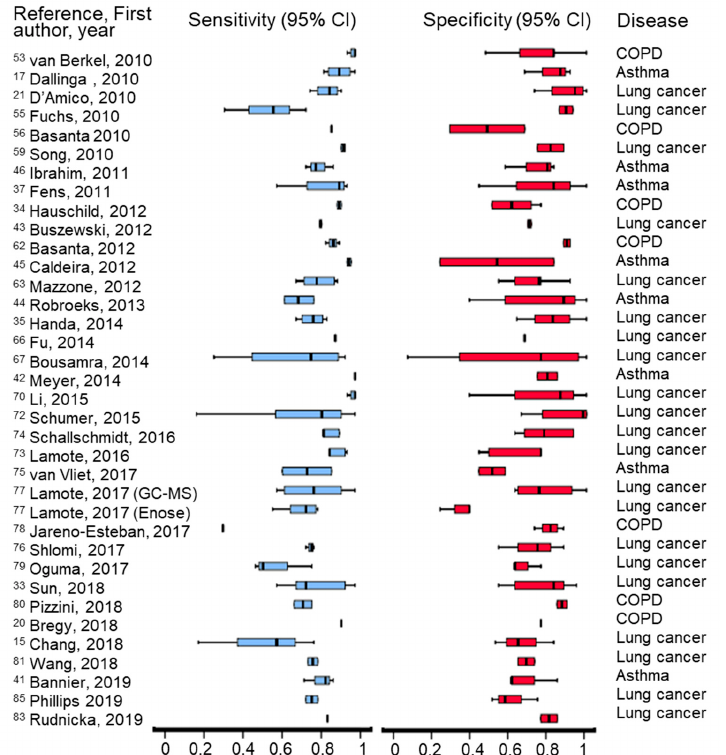
Figure 2. Graphical representation of recorded sensitivity and specificity obtained in the clinical studies included in the review, by using different analytical techniques.